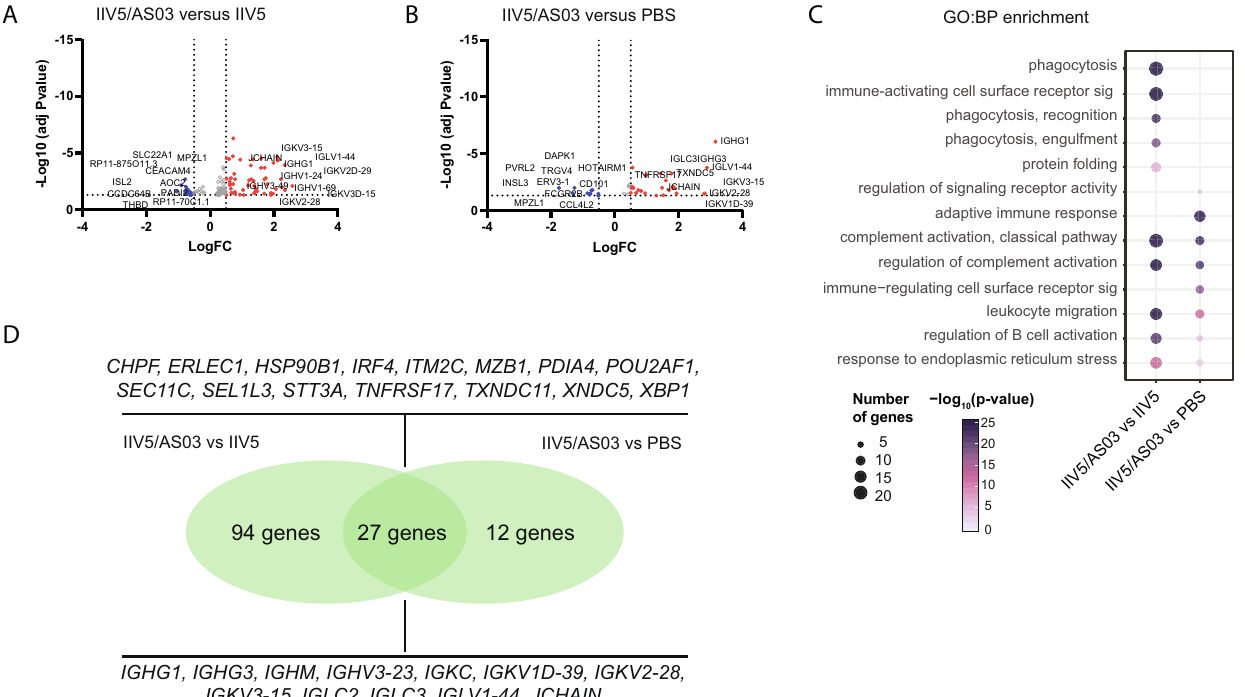
Fig. 7 Contribution of AS03 adjuvant to gene expression changes. A Volcano plots of upregulated (red) and downregulated (blue) genes in adjuvanted G1 (IIV5/AS03 booster) vs non-adjuvanted G2 (IIV5) post boost. Differences higher than 1.5-fold are highlighted and names for the top 10 genes are shown. B Volcano plots of upregulated (red) and downregulated (blue) genes in adjuvanted G1 vs placebo (G5) groups. C Gene ontology (GO) enrichment analysis of differentially expressed genes (DEGs) at day 7 after boost for the indicated comparisons. Diagram shows top 10 enriched biological processes. Gene ontologies are ranked by their signi fi cance and dot size indicates overlap on number of genes. The GO enrichment was performed with a ranked query and multiple testing analytical correction, FDR ≤ 0.05 or ≥ 0.3. D Venn diagram of DEGs for the comparison between G1 (IIV5/AS03 booster) versus G2 (IIV5), and G1 (IIV5/AS03 booster) − log 10 FDR versus G5 (placebo) at day